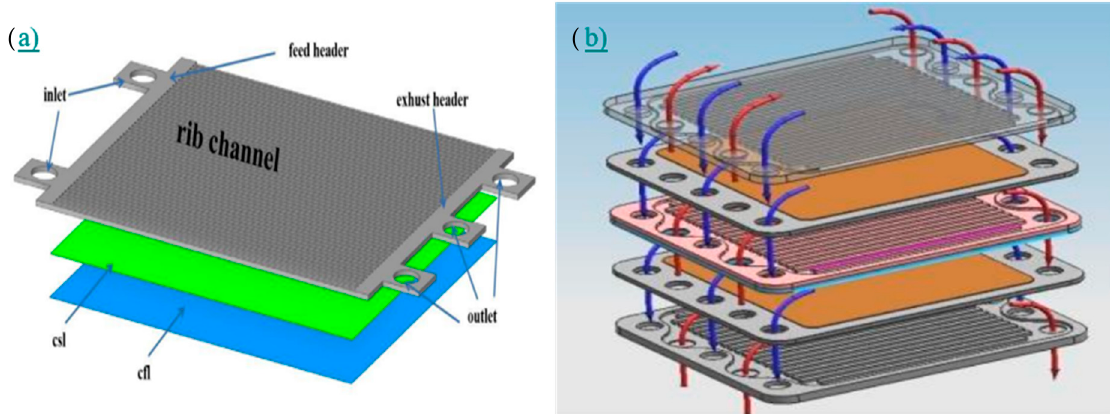
Figure 9. ( a ) Rib channel and electrode of a single layer; ( b ) architecture for a planar proton ceramic fuel cell stack. Reproduced from the reference [55], open access.